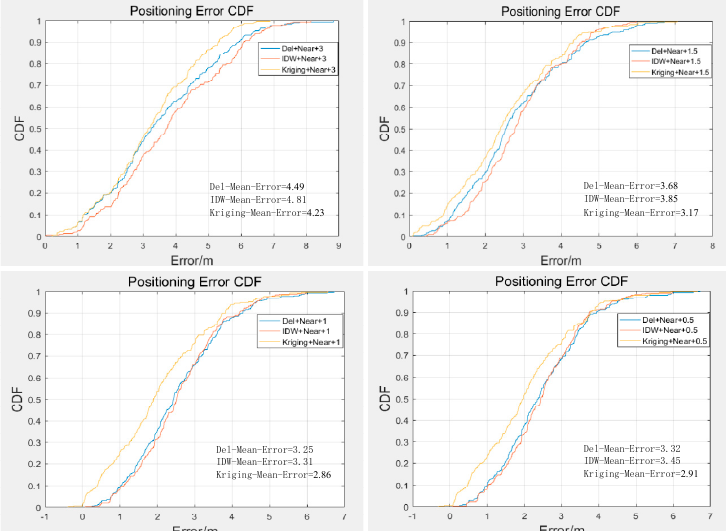
Figure 13. Cumulative distribution function (CDF) curves of different interpolation methods under different interpolation densities. Del, IDW and kriging represent the interpolation method, and the 3, 1.5, 1 and 0.5 represent the interpolation density (m).